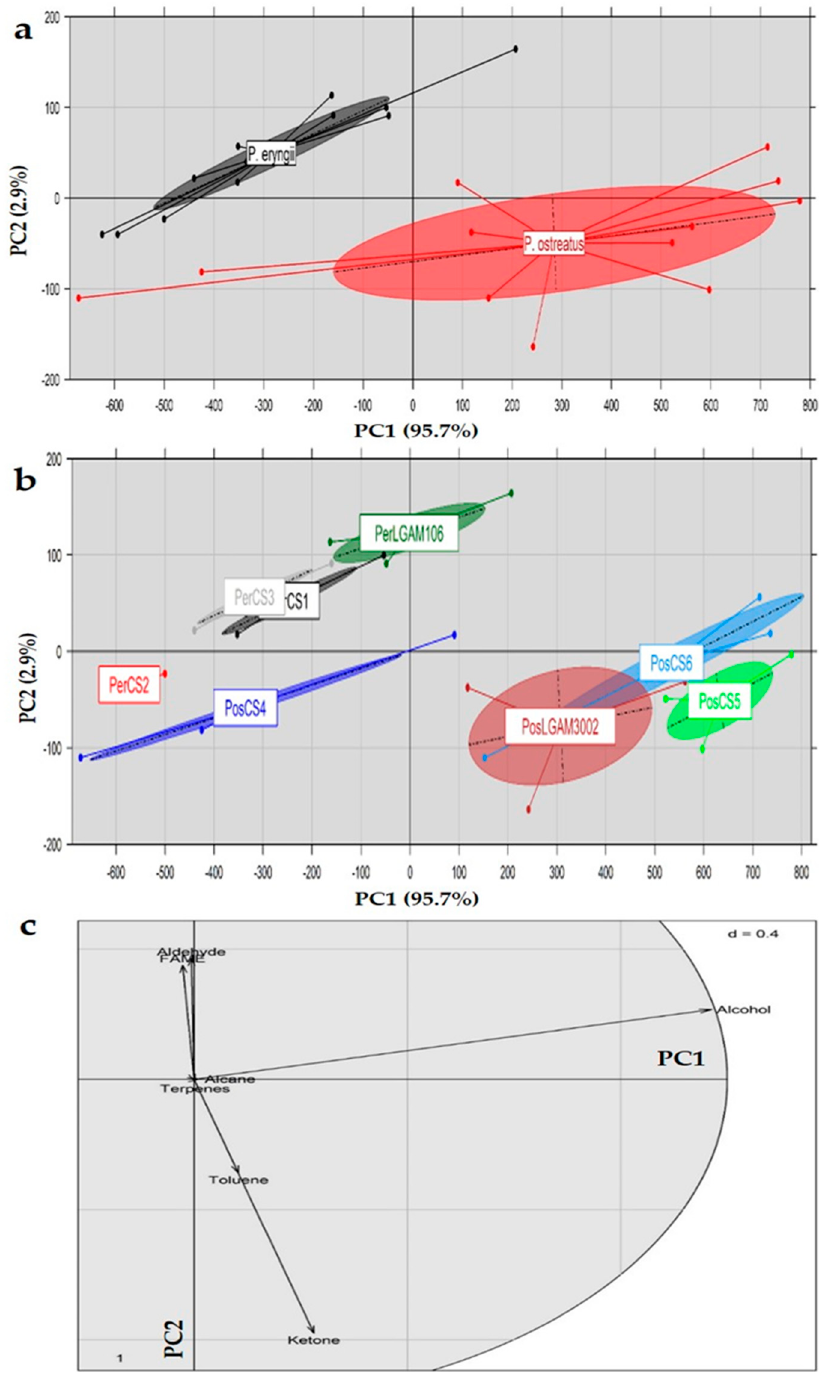
Figure 3. Score plot of principal component analysis and discrimination on the basis of classes of volatile compounds detected in Pleurotus mushrooms at ( a ) species and ( b ) strain level, as well as their ( c ) loadings. (Pos: P. ostreatus ; Per: P. eryngii ).